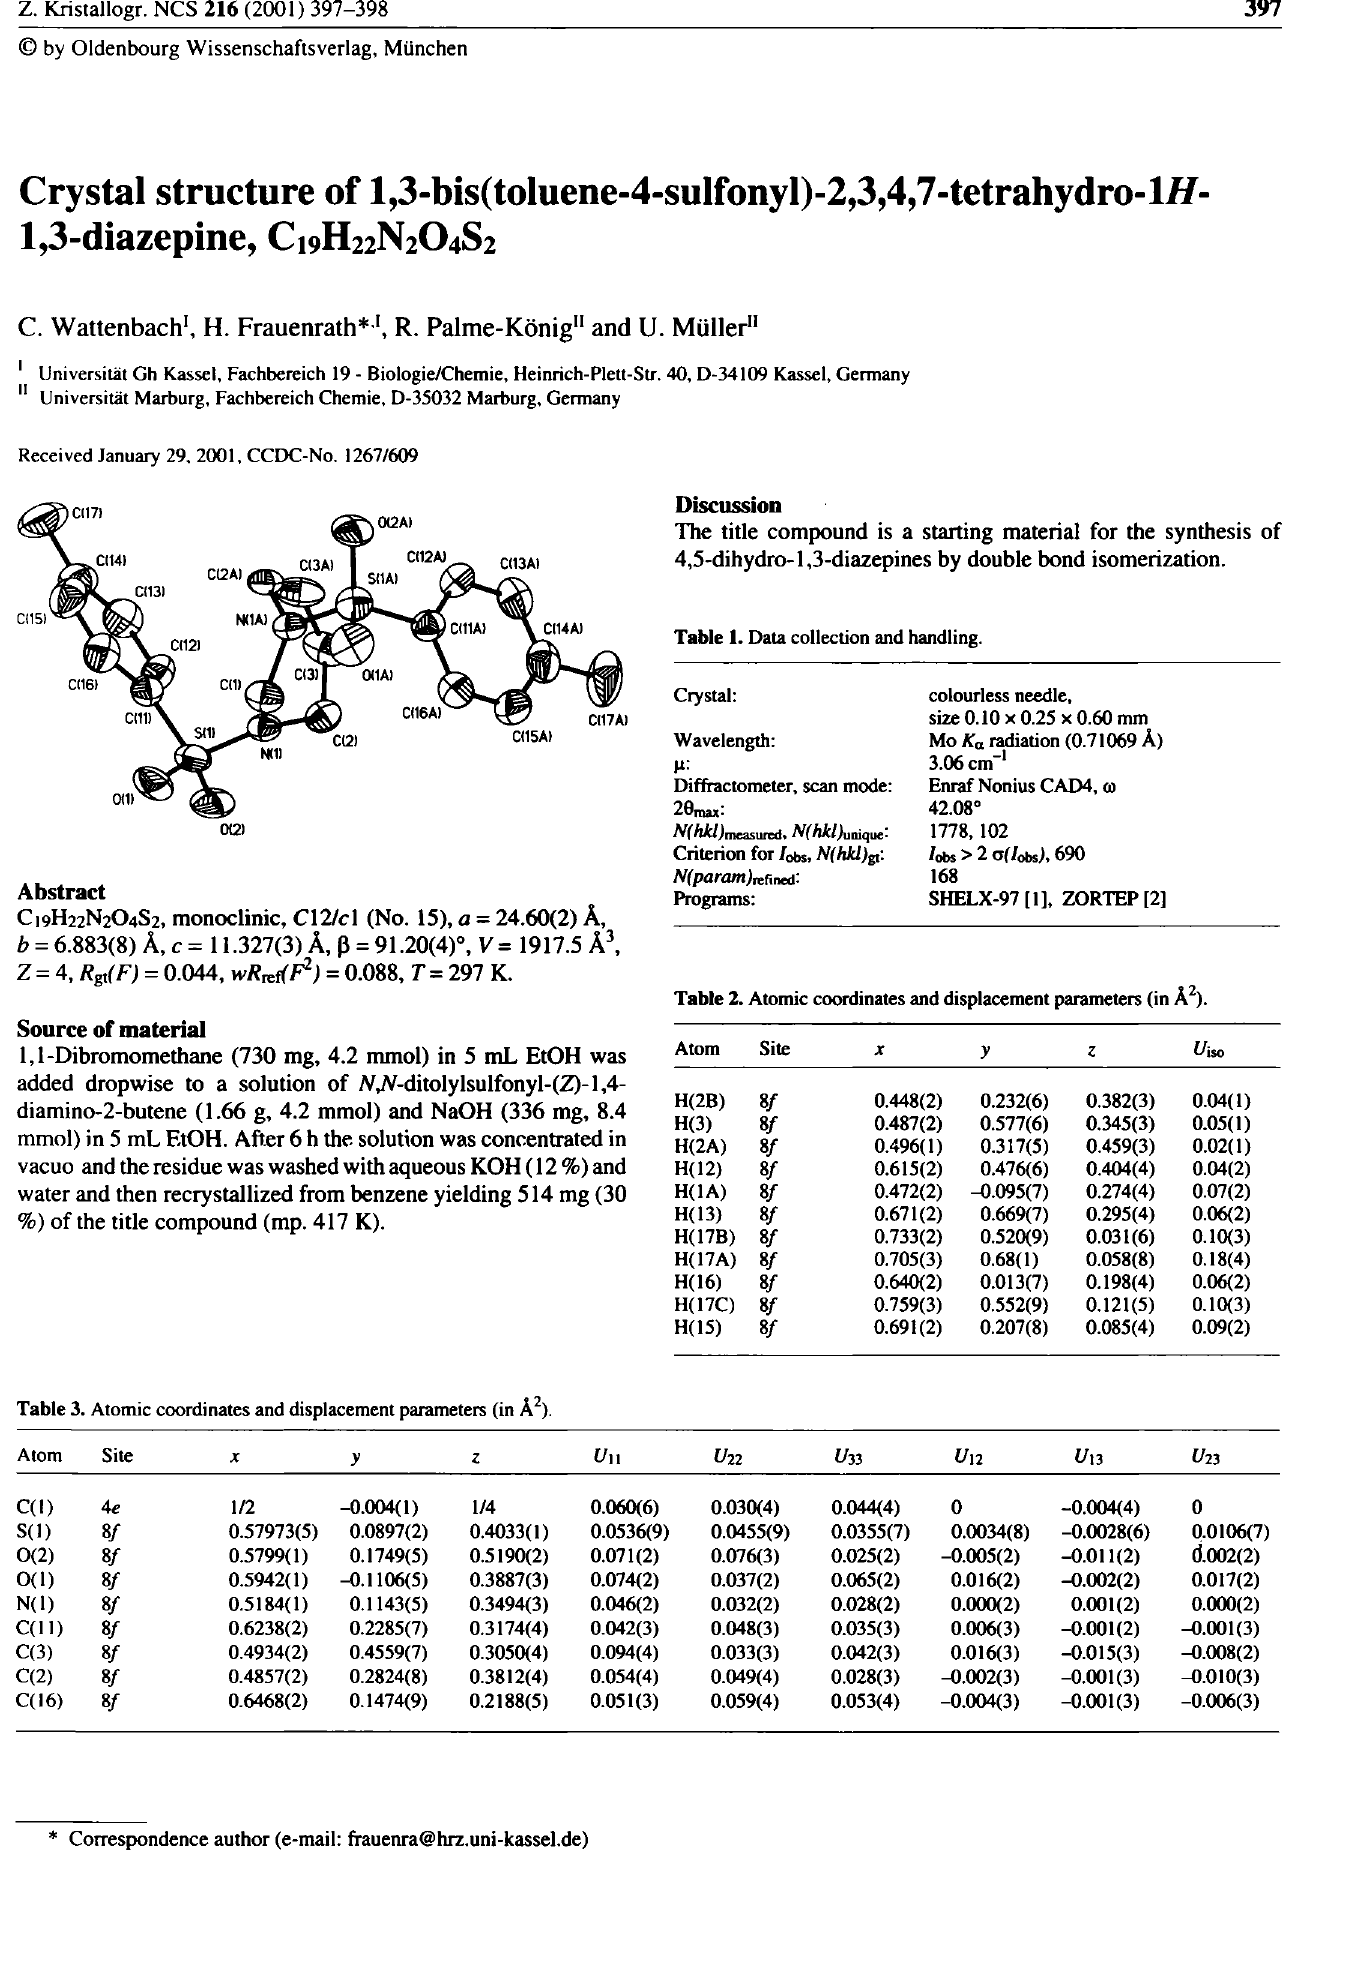
Table 1. Data collection and handling.